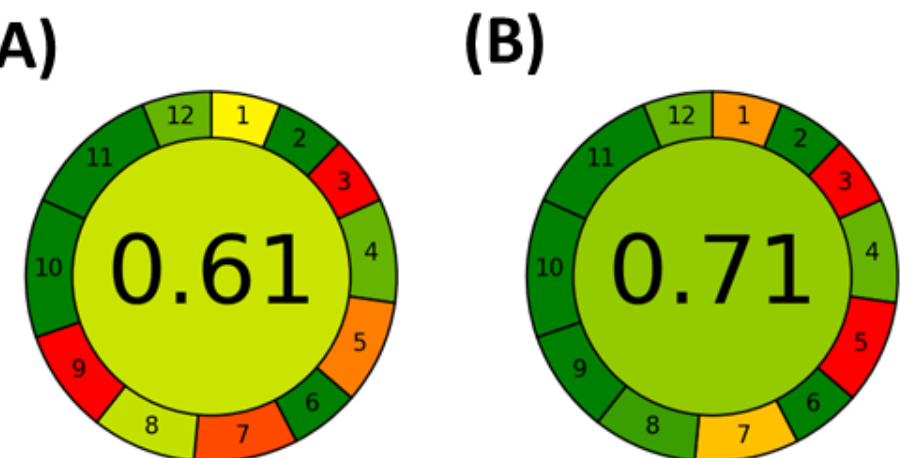
Figure 4. Evaluation of greenness of ( A ) GXLE a ( B ) UE plotted using AGREE software [32].